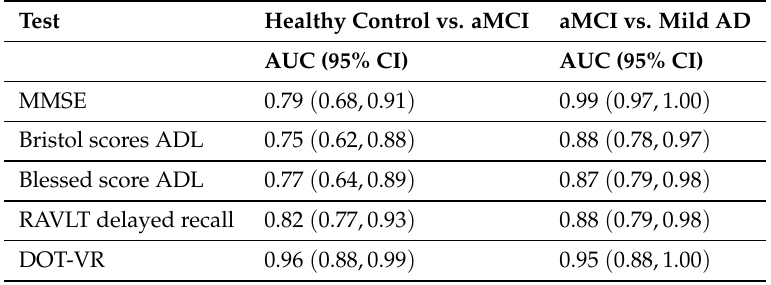
Table 2. Area under the curve (AUC) for standard neuropsychological test scores and Virtual Reality Day-Out Task (VR-DOT) for healthy controls versus patients with amnestic-type mild cognitive impairment (aMCI) and patients with aMCI versus patients with mild Alzheimer-type dementia (AD)